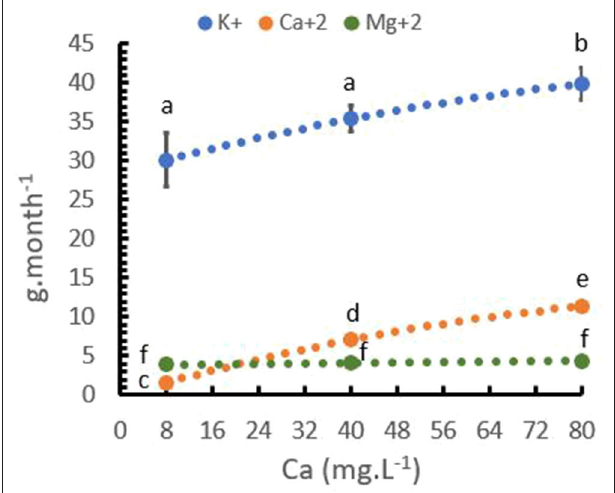
FIGURE 6 | Relationship between calcium (Ca + 2 ) rates and cation uptake rate per plant. Points represent the mean values for each of the replicates ± standard error. Different letters represent statistically significant differences among the treatments ( P < 0.05, LSD